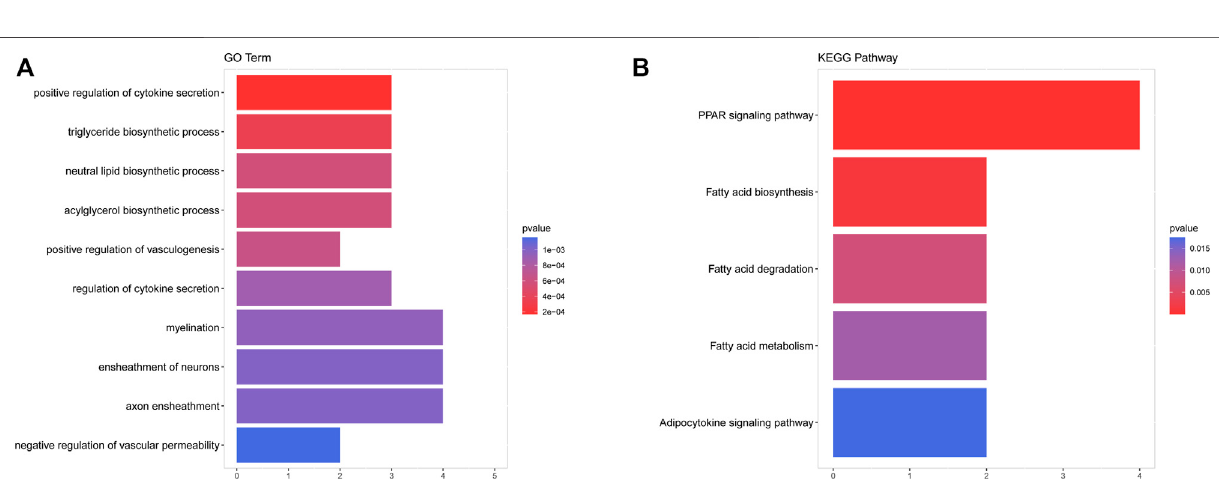
Frontiers in Genetics |